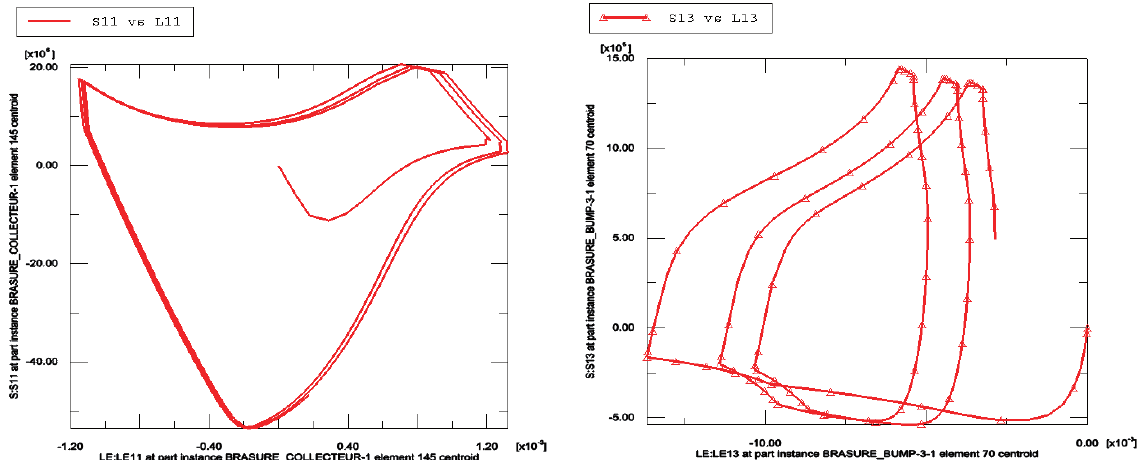
Fig. 21. Normal and shear stress versus strain, during thermal cycling without residual stresses